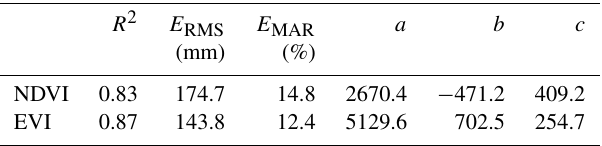
Table 4. Regression model performance and coefficients of regres- sion. R